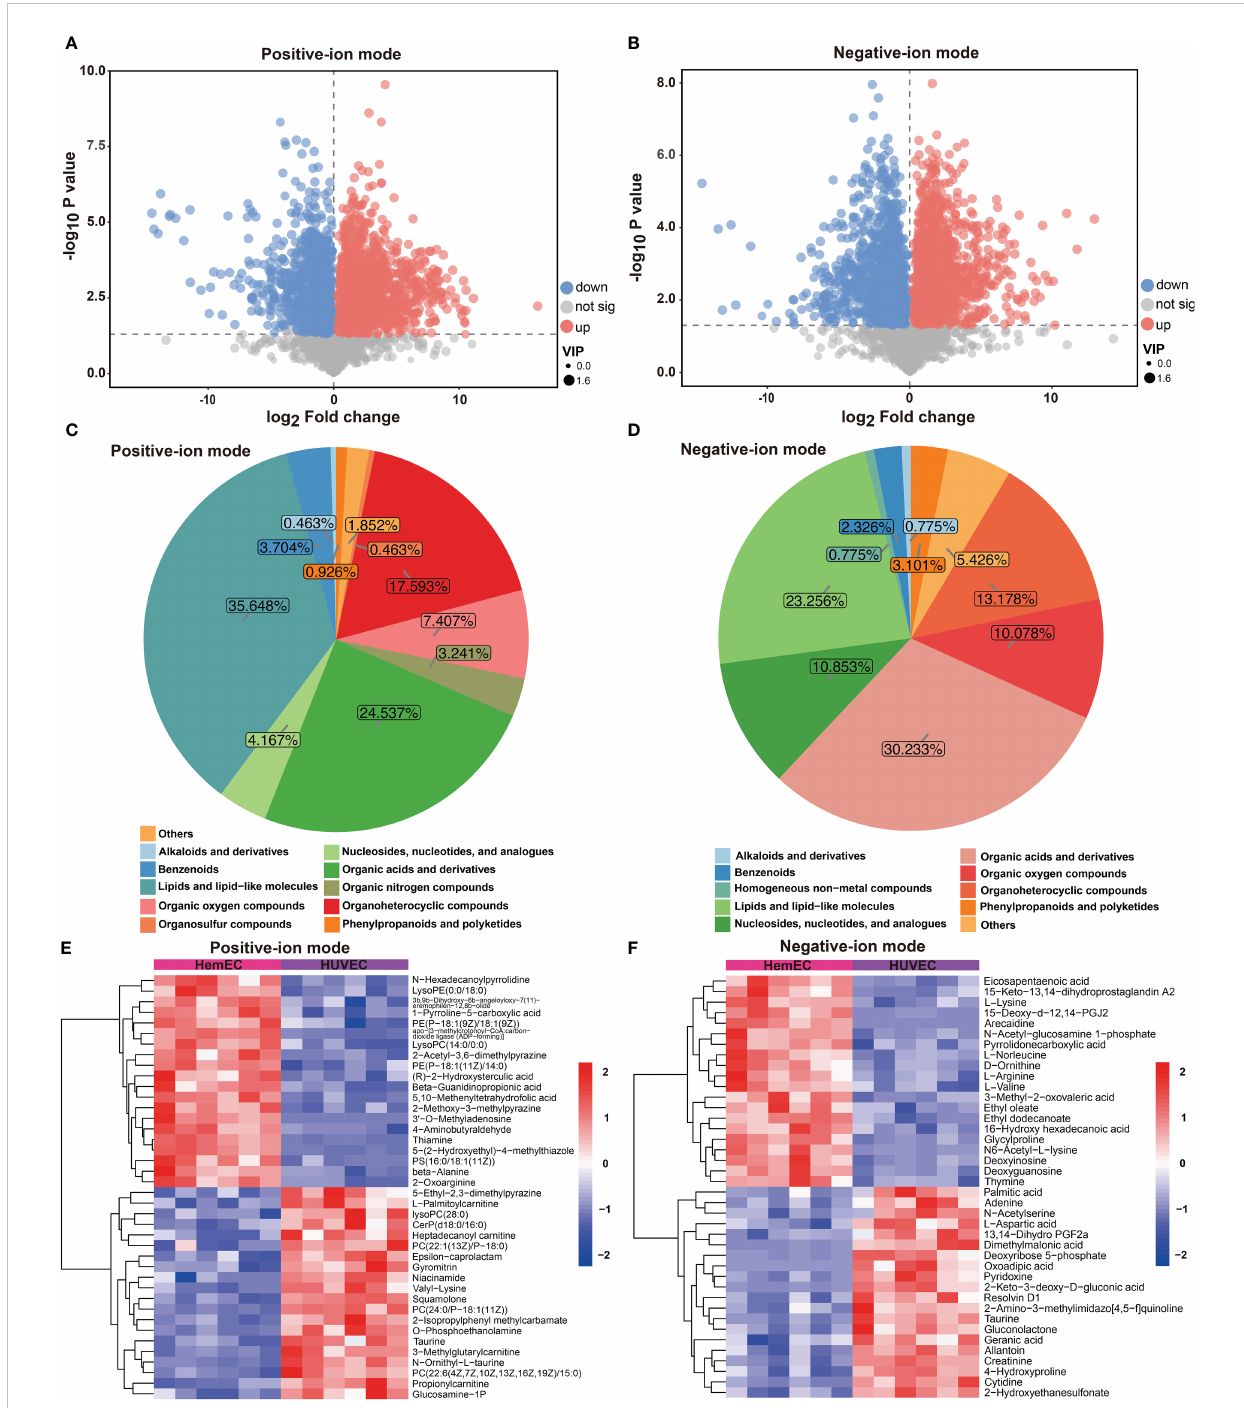
FIGURE 2 Differential metabolites (DMs) between HUVECs and HemECs by nontargeted metabolic analysis. (A, B) Volcano plot analysis of DMs with VIP value > 1 and P value <0.05 in both modes. (C, D) Distribution of all DMs in both modes. (E, F) Heatmap of hierarchical cluster analysis of the top 30 upregulated and downregulated DMs in both